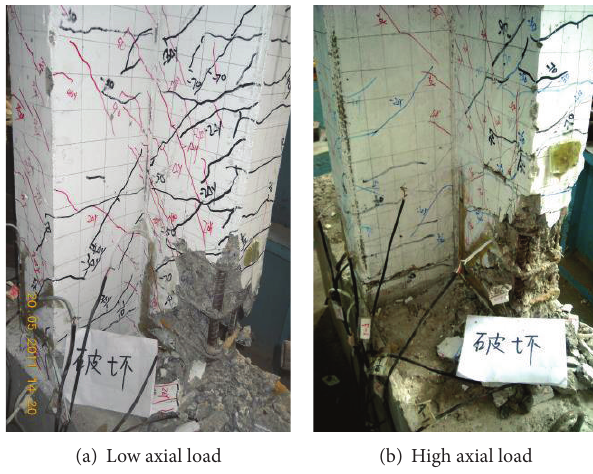
Figure 4: Failure mode of L-shaped columns.